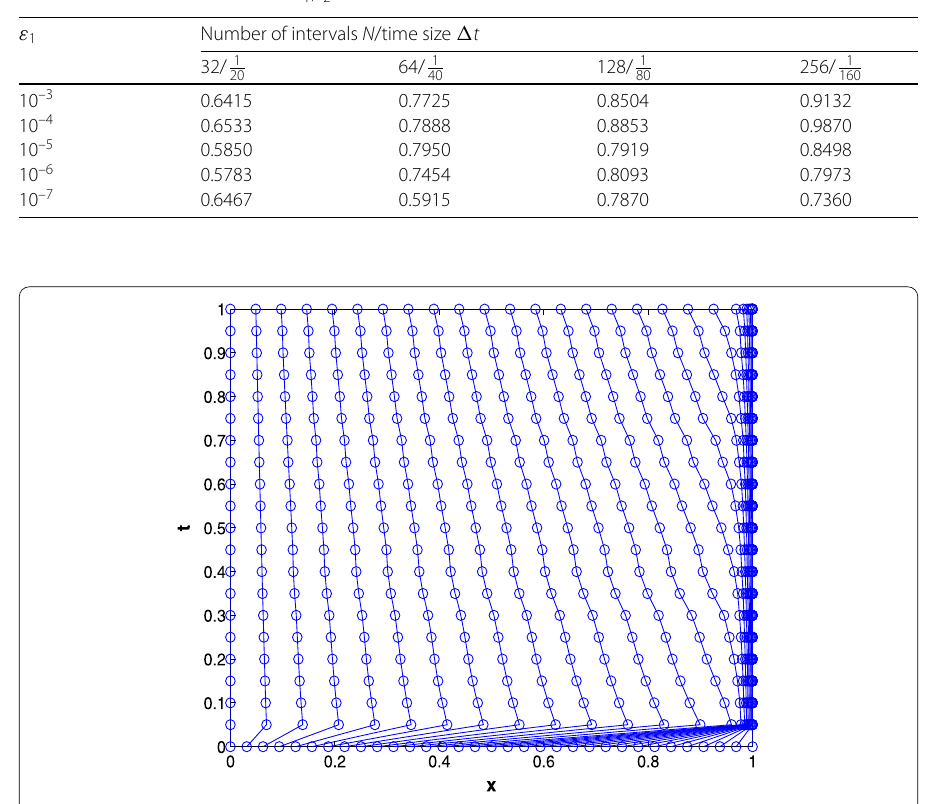
Figure 5 Grid movement of the algorithm for Example 5.2 with N = 32, M = 20, ε 1 = 10 –2 , and ε 2 = 10 –4